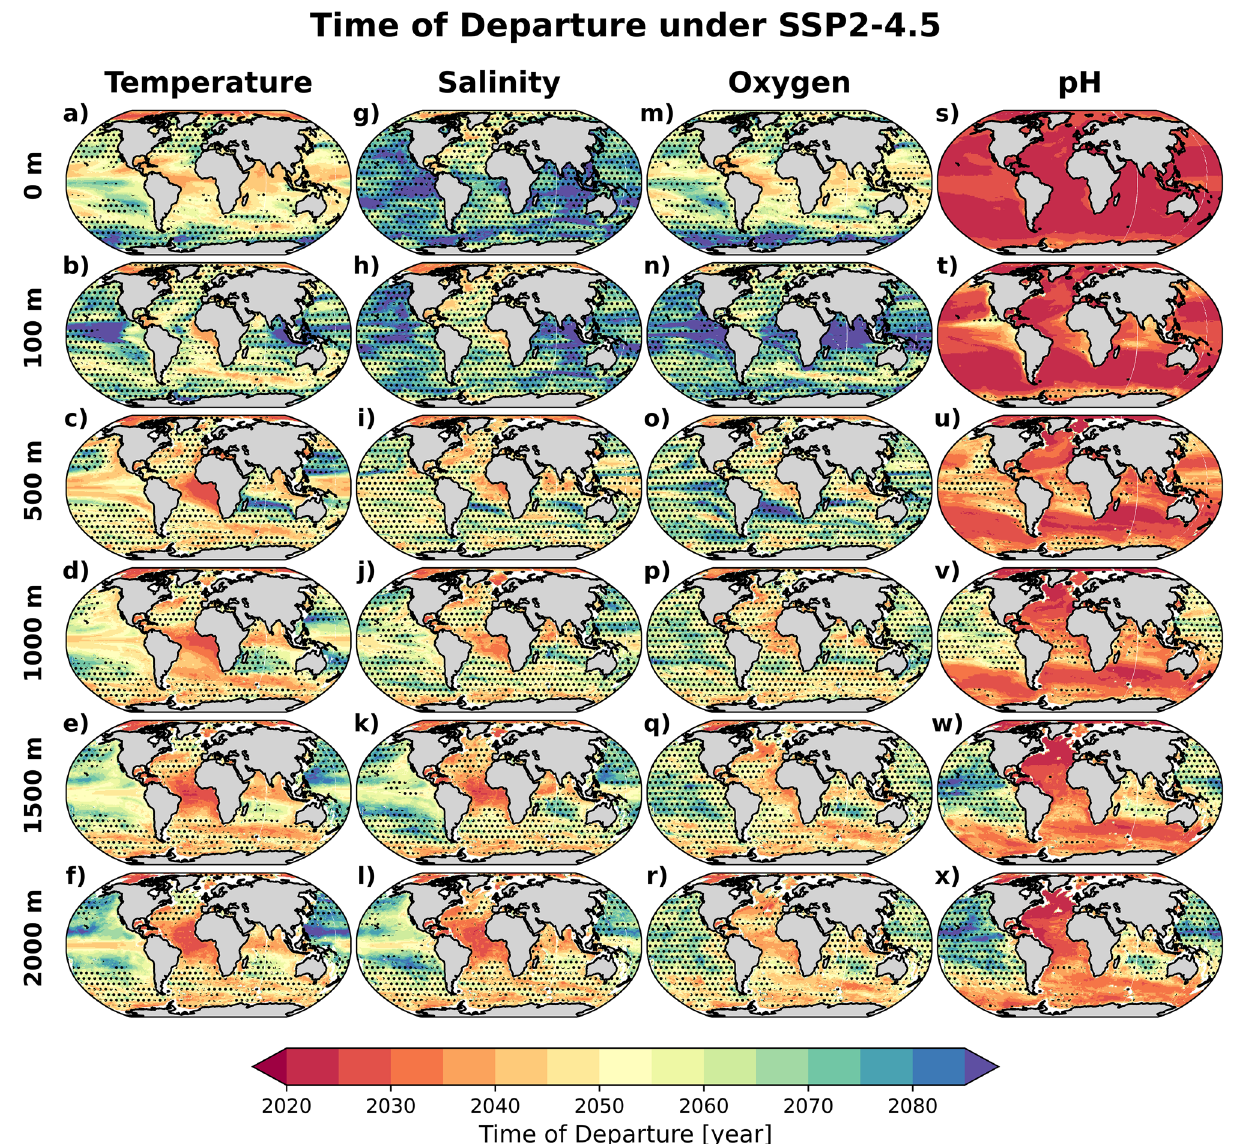
Figure 5. Time of Departure (ToD) maps for SSP2-4.5 scenario. Multi-model mean ToDs for ( a – f ) temperature, ( g – l ) salinity, ( m – r ) oxygen, and ( s – x ) pH for surface, 100 m, 500 m, 1000 m, 1500 m and 2000 m depths. Values are estimated from Earth system model projections under the SSP2-4.5 future scenario. The stippling marks areas where the inter-model standard deviation is above 20 years. Maps were generated with Python 3.9.16 using Matplotlib v3.6.2 (https:// matpl otlib. org/) and Cartopy v0.21.1 (https:// scito ols. org. uk/ carto